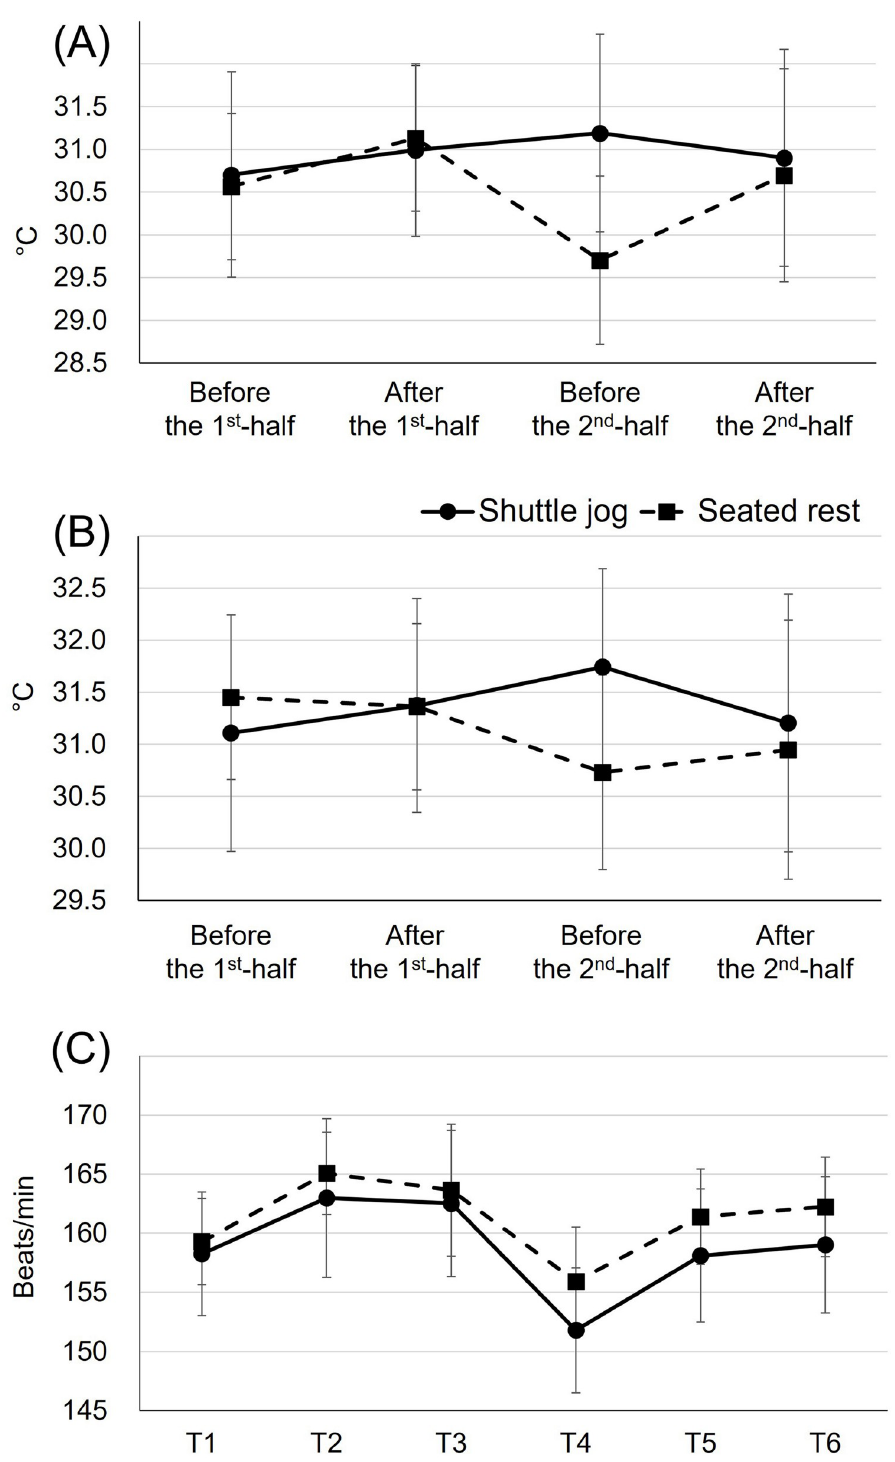
Fig 5. Changes in lower-leg skin (A) and muscle (B) temperature, and heart rate (C) over time. Values are means and the upper and lower bounds of 95% confidence intervals.